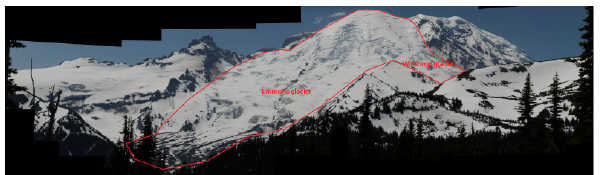
Figure A3. Photomosaic acquired from SUNRIZ viewpoint on 7 July 2012. Approximate glacier outlines shown in red.